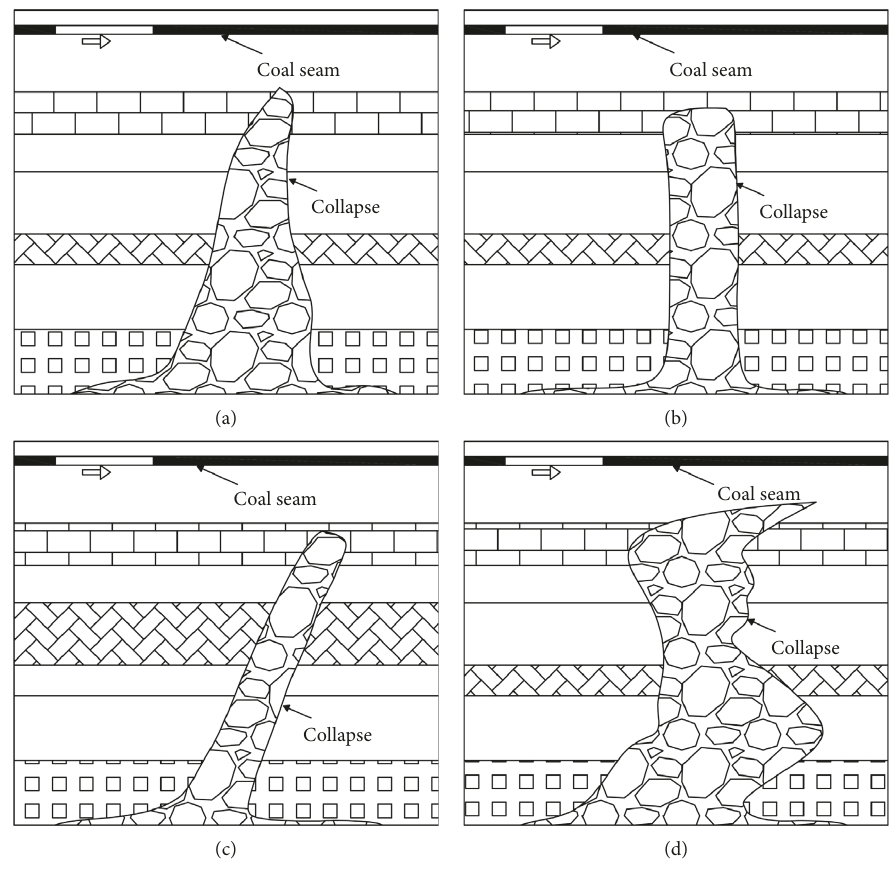
Figure 1: Four types of collapsed